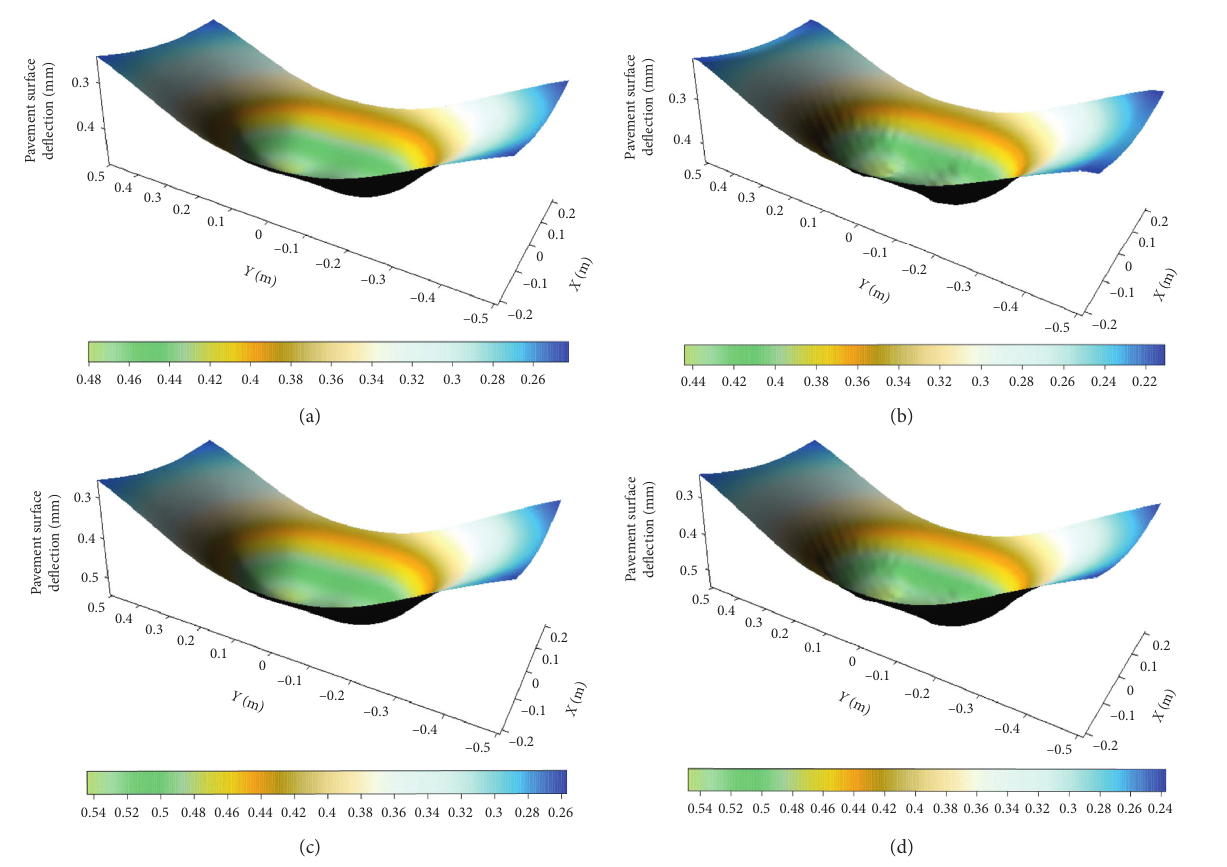
Figure 6: Spatial distribution of pavement surface deflections of the two programs (unit: mm): (a) BISAR (fully bonding of the interface between the base-surface layers); (b) EverStressFE (fully bonding of the interface between the base-surface layers); (c) BISAR (fully slipping of the interface between the base-surface layers); (d) EverStressFE (fully slipping of the interface between the base-surface layers).